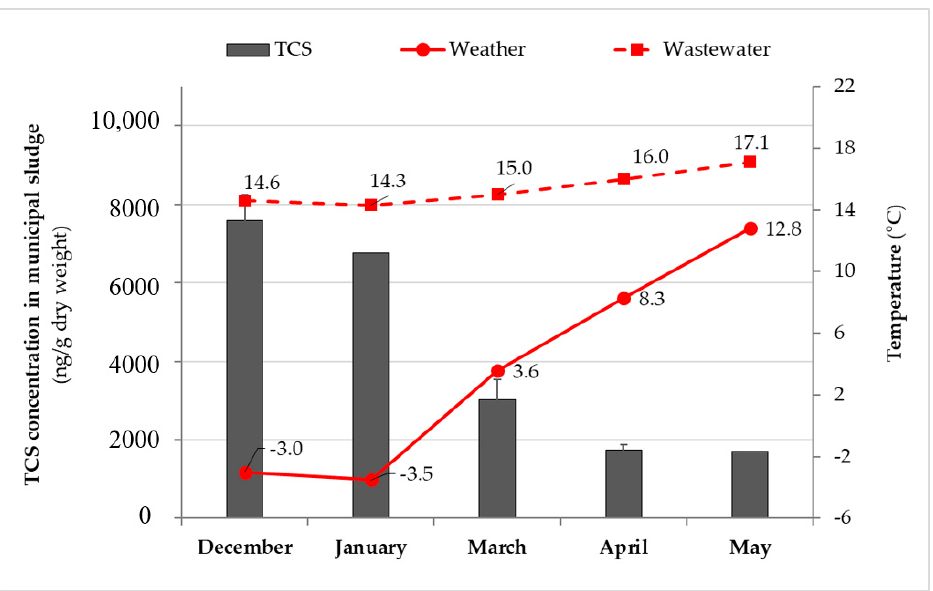
Figure 1. Seasonal variation in the occurrence of triclosan (TCS) in undigested mixed sludge during different sample collection periods coupled with average wastewater and weather temperatures.